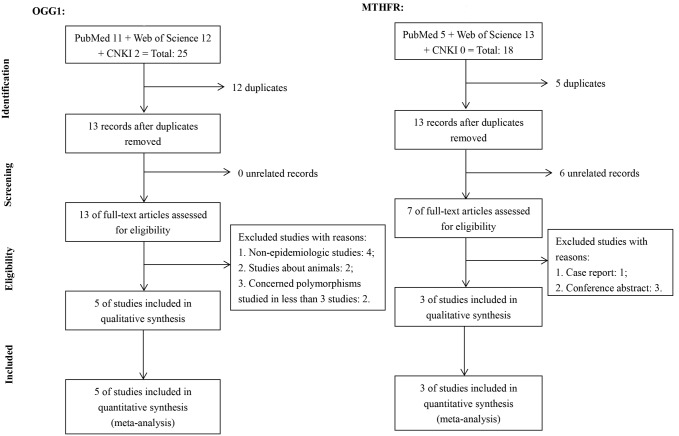
PRISMA flow diagram.